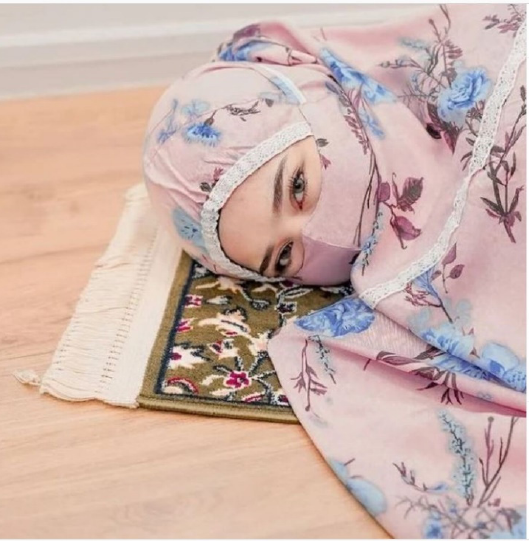
Figure 3. Instagram Post of nanazulkar_, https://www.instagram.com/p/CY8mEEFpwD2/ (accessed on 20 January